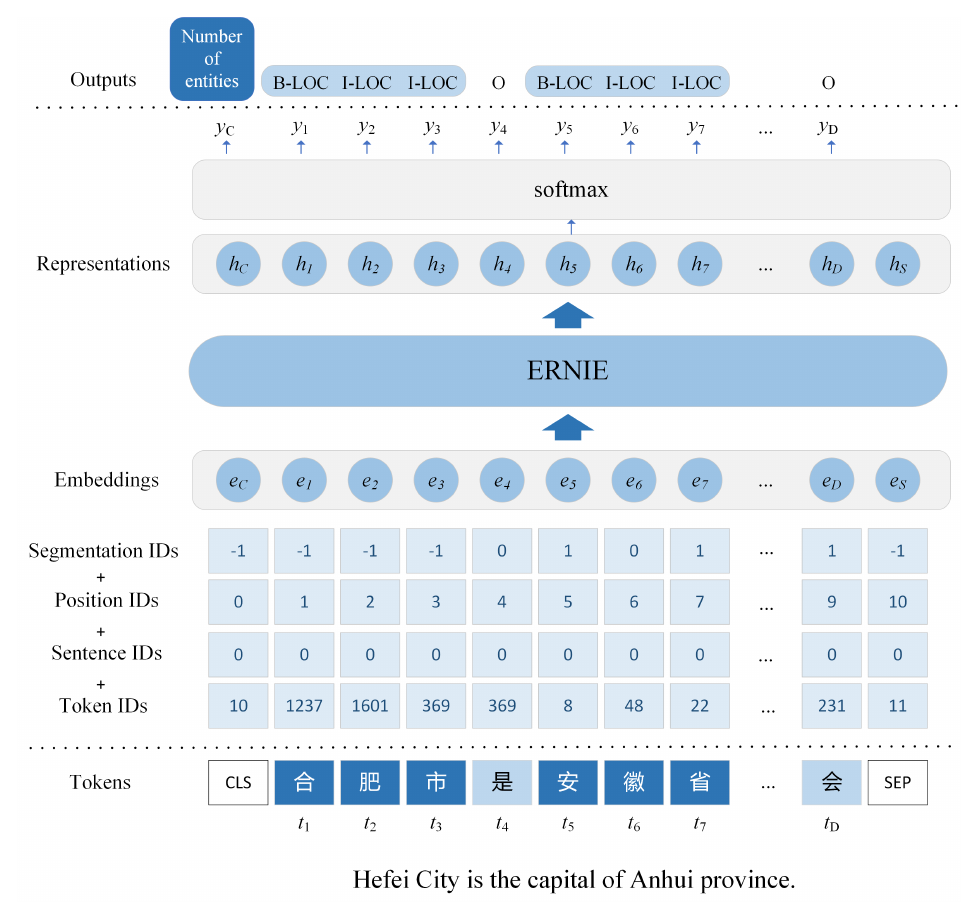
Figure 4. The architecture of